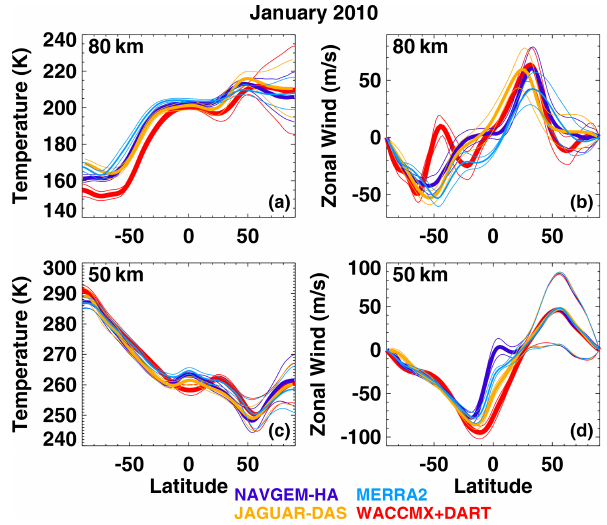
Figure 4. Latitude dependence of January 2010 average zonal mean temperature (a,c) and zonal wind (b,d) at 80km (top) and 50km (bottom) for NAVGEM-HA (purple), MERRA-2 (light blue), JAGUAR-DAS (gold), and WACCMX + DART (red). Thick curves indicate the monthly zonal mean values, and thin curves indicate ± 1 standard deviation of the daily